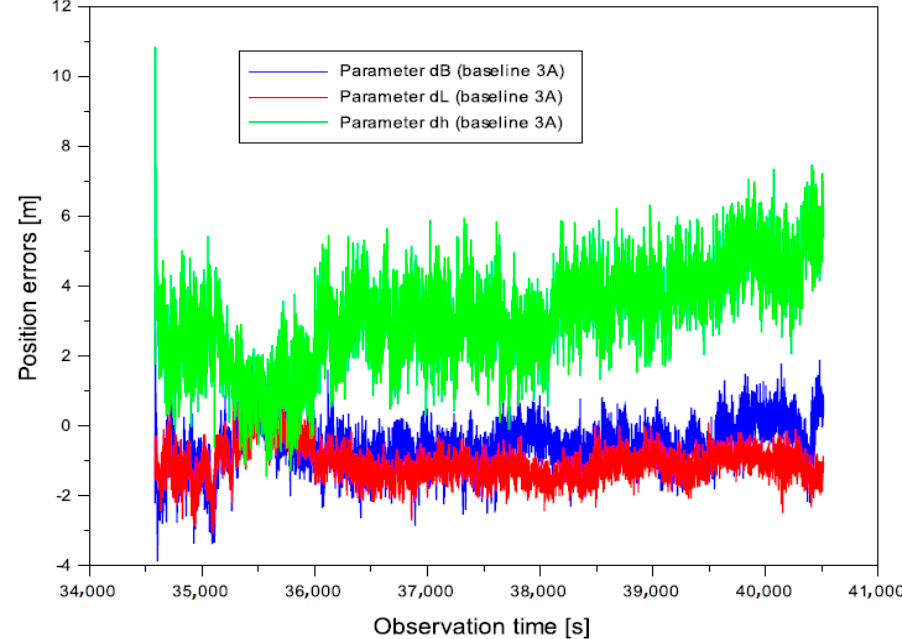
Figure 4. The results of position errors for baseline 3 A .